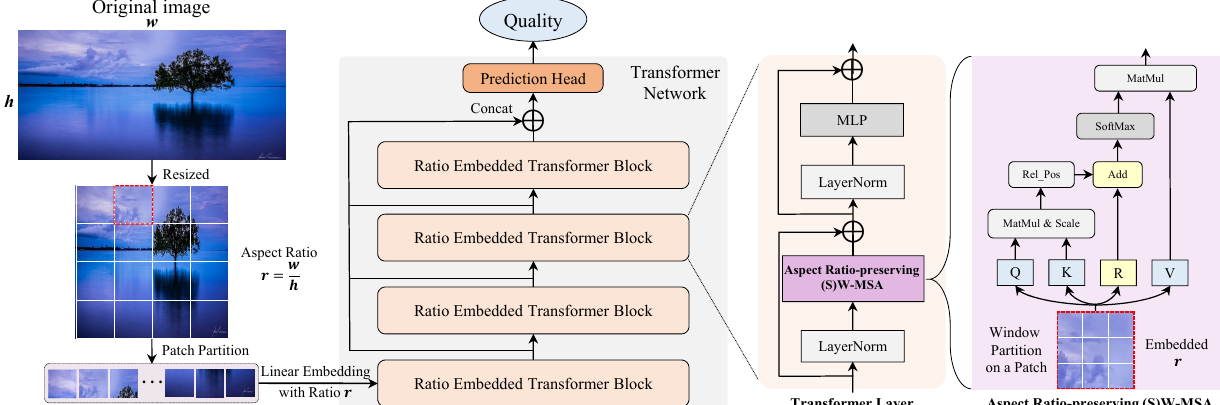
Figure 2. The overview framework of the proposed IQA method, which is based on a typical Swin Transformer model. First, the warped image with a fixed size is split into nonoverlapping patches and the patches and original aspect ratios are embedded into the Transformer blocks. Then, we propose an aspect-ratio-preserving (shifted) window-based multihead self-attention ((S)W-MSA) in each ratio-embedded Transformer block. Finally, the perceptual quality of images can be jointly inferred by combining the multistage Transformer blocks through a prediction